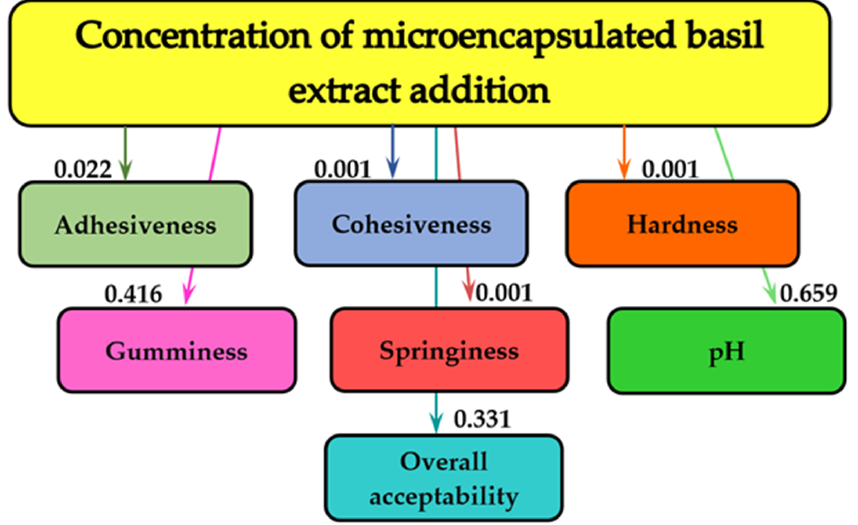
Figure 4. The informational analysis for the influence of the concentration of the MBE added on the textural parameters, the pH, and on the overall acceptability of cream cheese samples.